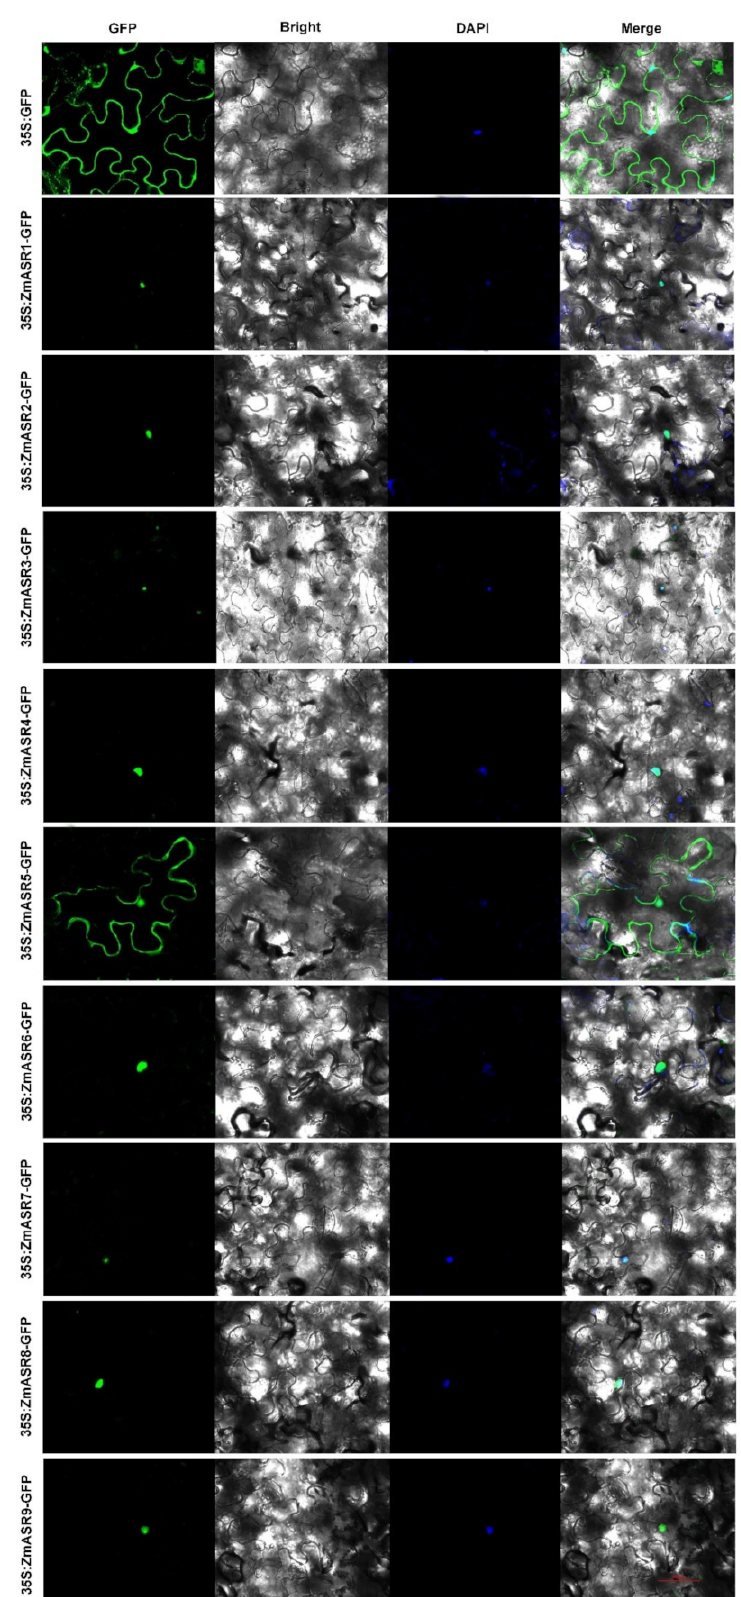
Figure 3. Sub-cellular localization analysis of ZmASRs. Sub-cellular localization of the ZmASR-GFP constructs in tobacco leaf epidermal cells. Green color is GFP protein signal, and blue color represents DAPI stained for nucleus. Scale bar = 50 µ